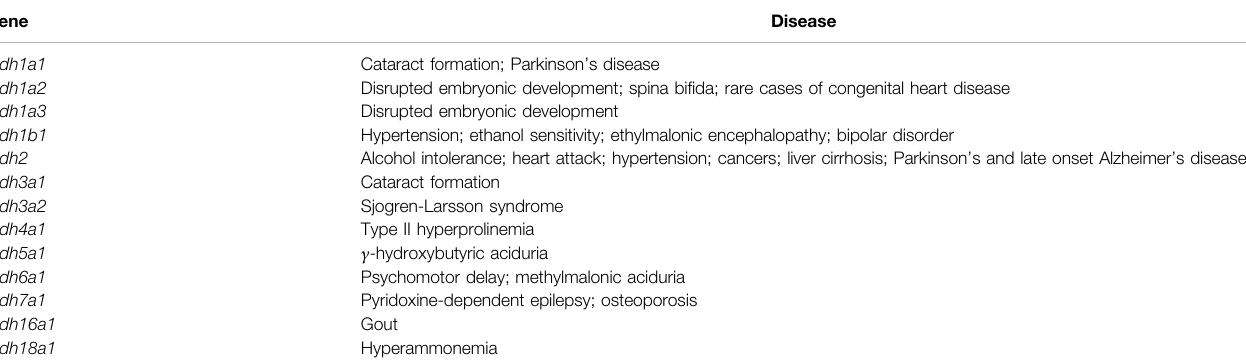
TABLE 2 | Human diseases linked to ALDH genes. Gene